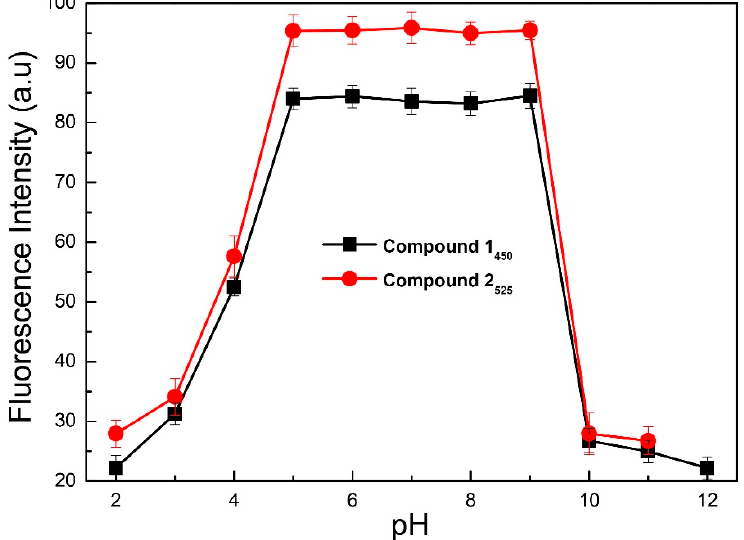
Figure 4. Effect of pH on the emission intensities of 1 and 2 , in H 2 O:DMF (9:1) containing HEPES buffer (10 mM, pH 7.4). ( λ ex = 330 nm).